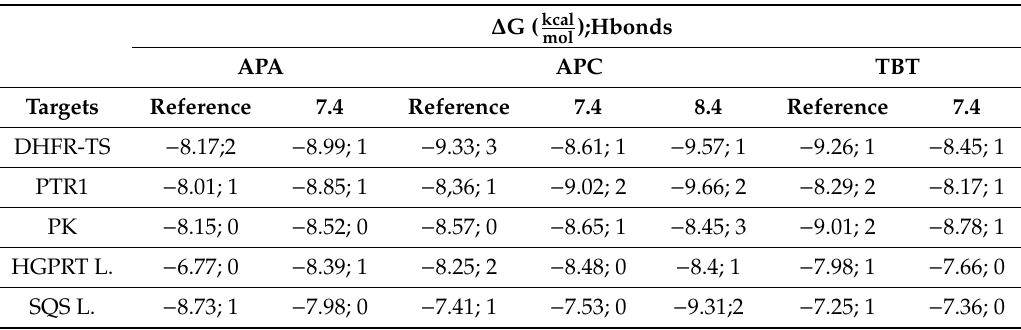
Table 4. Predicted binding free energy and hydrogen bonds. A. spruceanum metabolites were docked in the selected Leishmania targets. Reference, 7.4 or / and 8.4 indicate pH of the